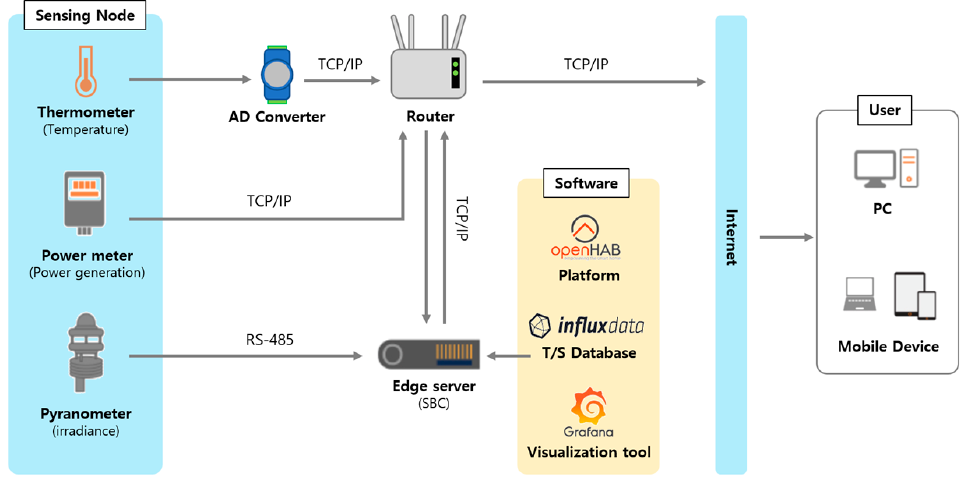
Figure 4. Schematic of the PV remote monitoring system.